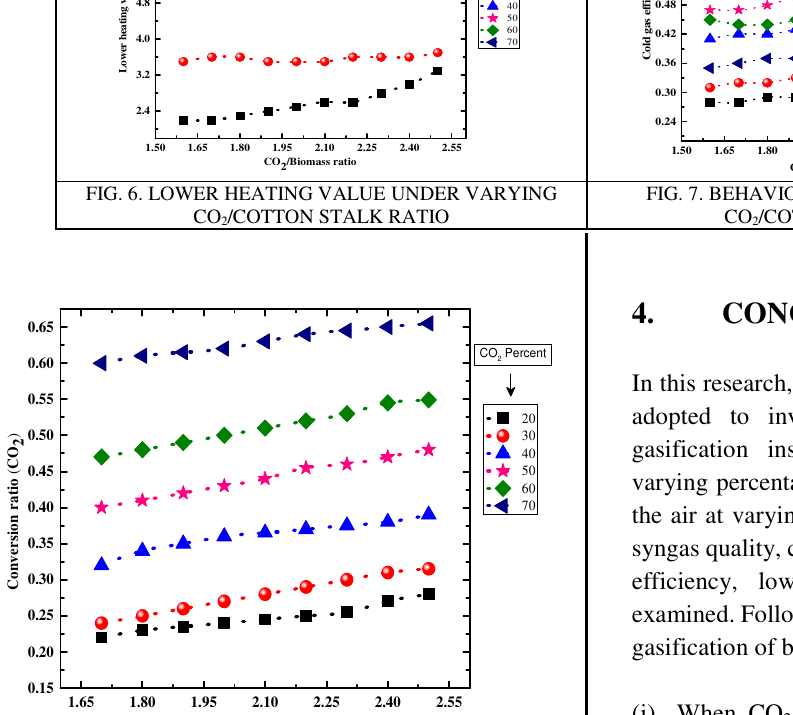
FIG. 8. CONVERSION OF CO 2 UNDER DIFFERENT CO 2 COTTON STALK